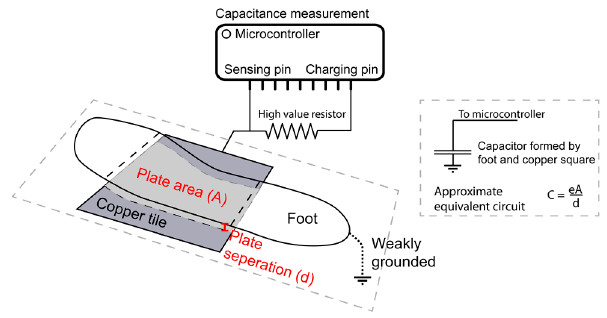
Figure 1. Loading mode capacitor formed by a subject’s foot.